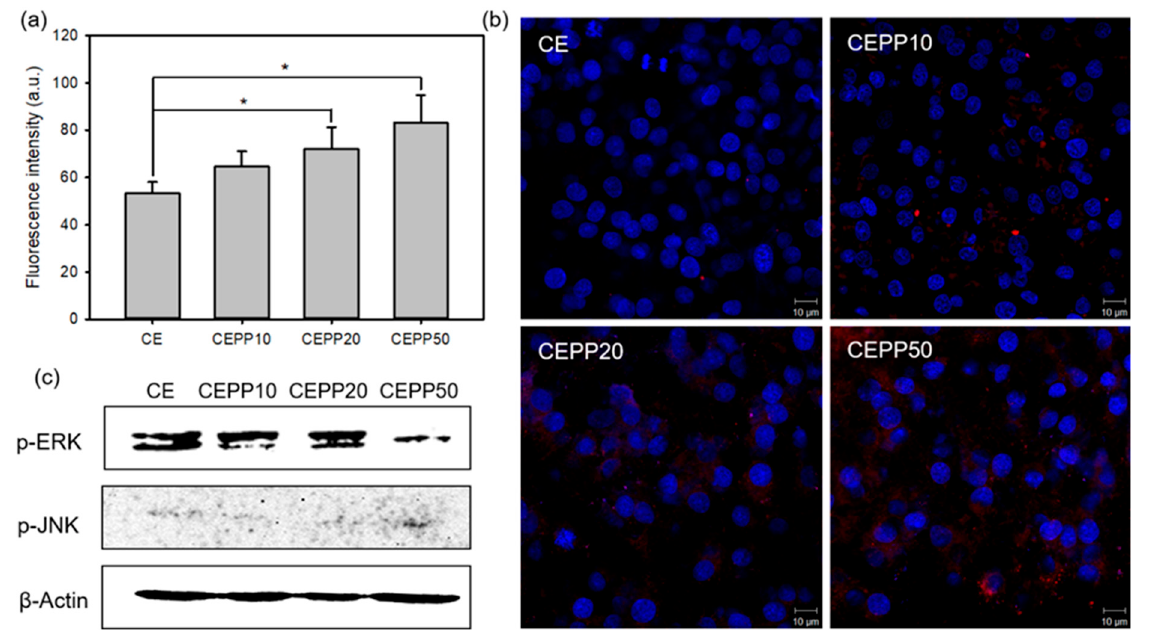
Figure 7. ( a ) DCF fluorescence intensity measured using a flow cytometer for determining the intracellular ROS level in the S16 cells culture on the CEPP monoliths after treatment with laser irradiation. The error bars indicate mean values ± SD ( n = 5). * p ˂ 0.05 for the comparison between the two treatment groups. ( b ) Confocal laser scanning microscopy images of the intracellular distribution of ROS in the S16 cells grown on the CEPP monoliths after being irradiated with a 635 nm laser. ( c ) Representative Western blots for phosphorylated ERKs and JNKs in lysates of S16 cells cultured on the CEPP monoliths after treatment with laser irradiation. β -Actin was used as the loading control.